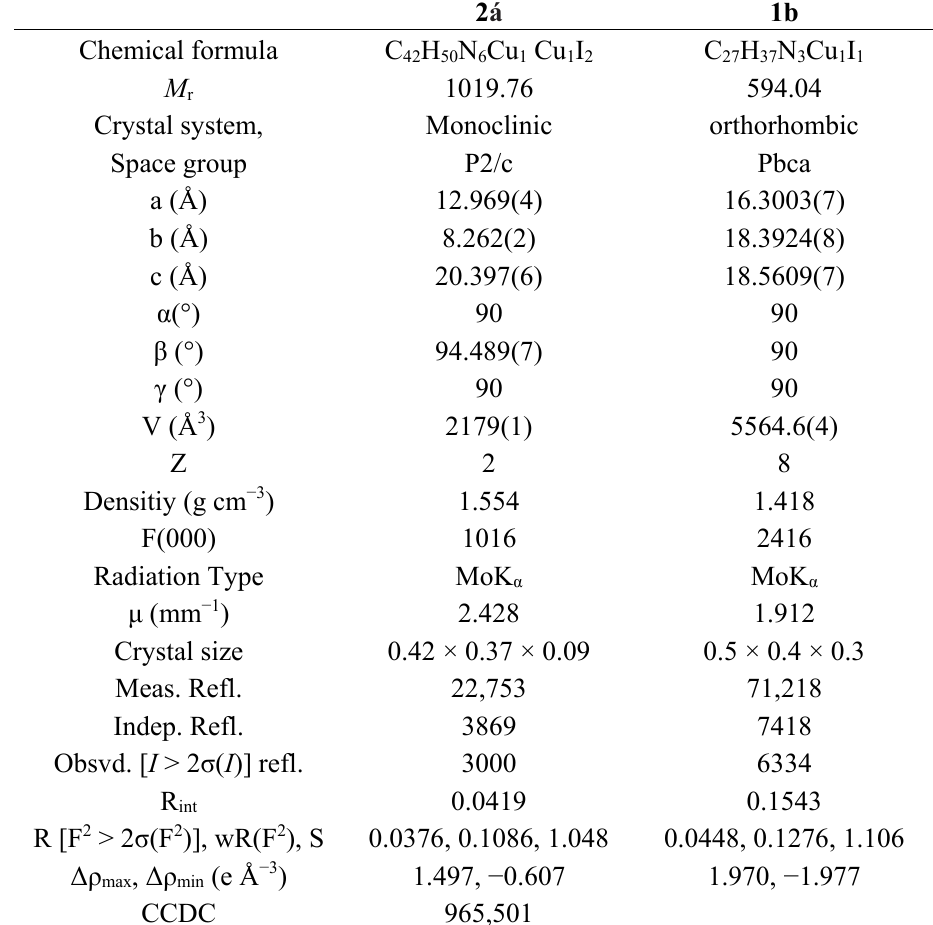
Table 1. Crystallographic information for complexes 2á and 1b